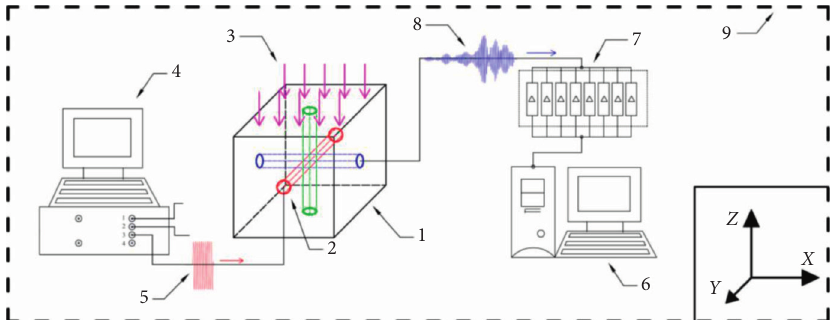
Figure 1: Schematic diagram of transducers arrangement. (1) The rock sample; (2) ultrasonic transducers; (3) press; (4) ultrasonic signal transmitting terminal; (5) transmitted sine signal; (6) ultrasonic signal receiving terminal; (7) preamplifier; (8) received signal; (9) shielding room.